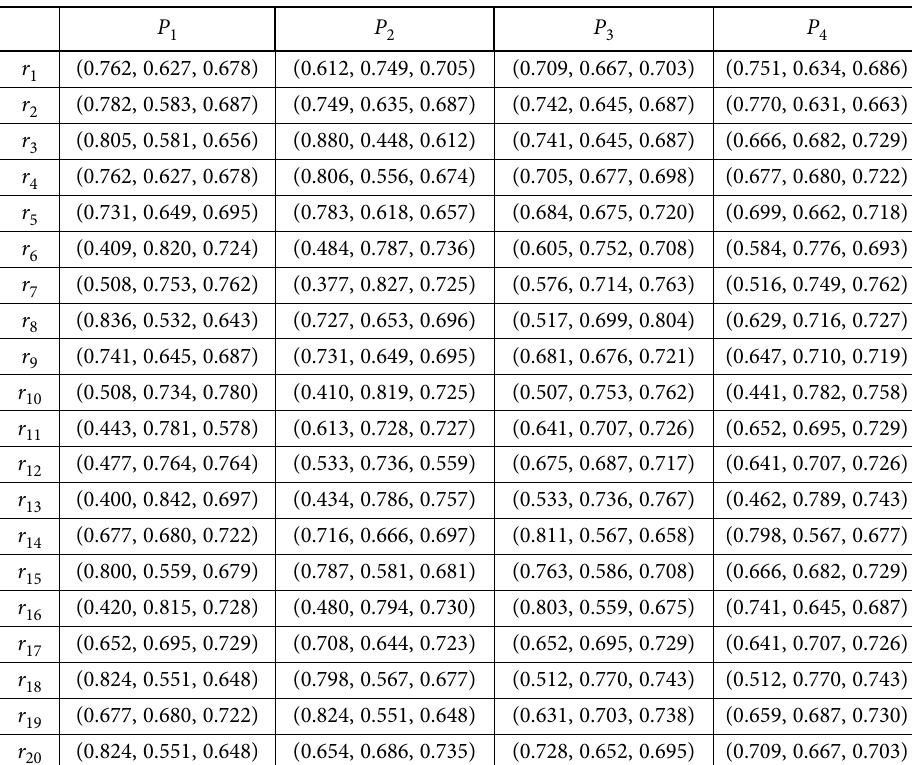
Table 4. A-q-ROF-DM for IoT risks for